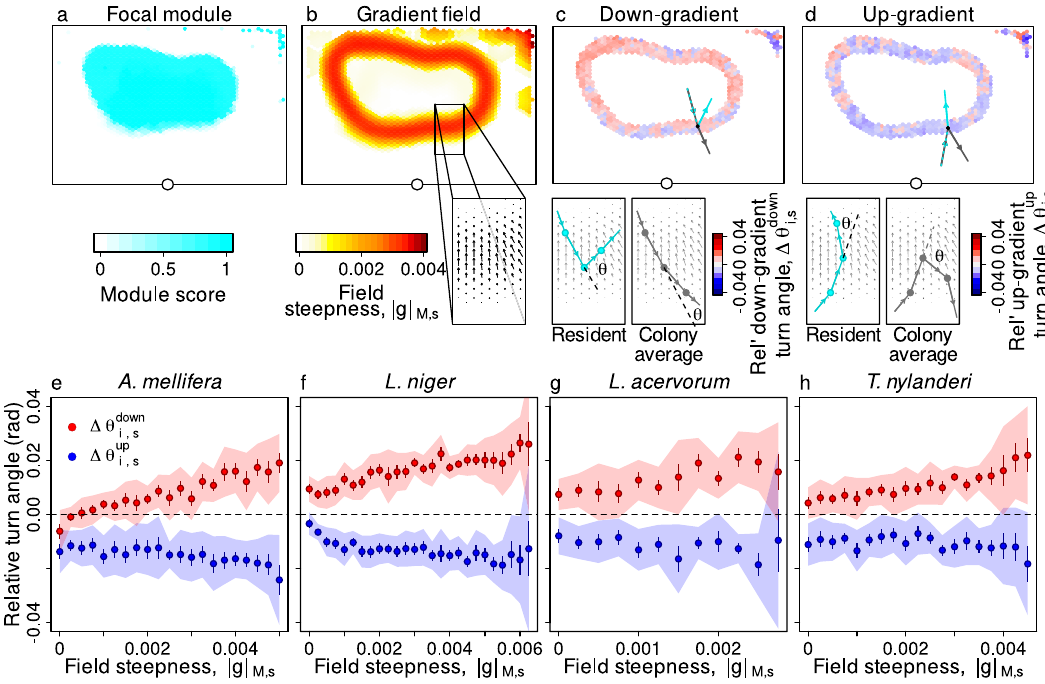
Fig. 8 | Worker navigation within module gradient fi elds. Panels ( a – d ) illustrate likelythanaveragetoleavethefocalmodule).Blow-upsin d :residentsheadingup- gradient ( (cid:1) θ up i , s , M ) exhibit smaller turn angles than the average worker ( (cid:1) θ up s , M ) and so the direction-dependent modulation of turning behaviourwithinthegradient fi eld i i generally have negative relative turn angles (i.e, are more likely to enter the focal foranexamplefocalmodule(thenursemoduleofthesame L.acervorum colonyas module). e – h Relativeturnanglesforworkersheadingdown-orup-gradient(red& showninFig.7). a , b Calculatingthegradient fi eld. a Modulescoremapforthefocal blue respectively) of their primary module, as a function of the gradient fi eld module. b Thefocalmodulegradient fi eld,derivedfromlocalspatialregressionson steepness.Allmodulesandallworkerswereincludedinthisanalysis.Points&error thesitescores.Theblow-upshowsatransectacrosstheborder.Arrowheadingand bars represent grand means and standard errors, calculated from the 50 colony length indicate respectively the fi eld direction and steepness. c , d Relative turn means. Shaded areas represent the 95% con fi dence intervals after Bonferroni cor- anglesforresidents(inthisexample,nurses)andnon-residentsheadingdown-and rections. The dashed line represents the null expectation that residents and non- up-gradient in the fi eld of the focal (nurse) module. Blow-ups in ( c ): residents ) exhibit larger residents behave in the same way when approaching the module border. All ana- heading down-gradient in the fi eld of their primary module ( (cid:1) θ down i , s , M i turnangles thanthe average worker heading down-gradient atthe same site inthe lysesbasedon n =613100sites,and n =12494workers,drawnfrom n =50colonies. same fi eld ( (cid:1) θ down s , M ), and so generally have positive relative turn angles (i.e., are less Source data are provided as a source data fi i